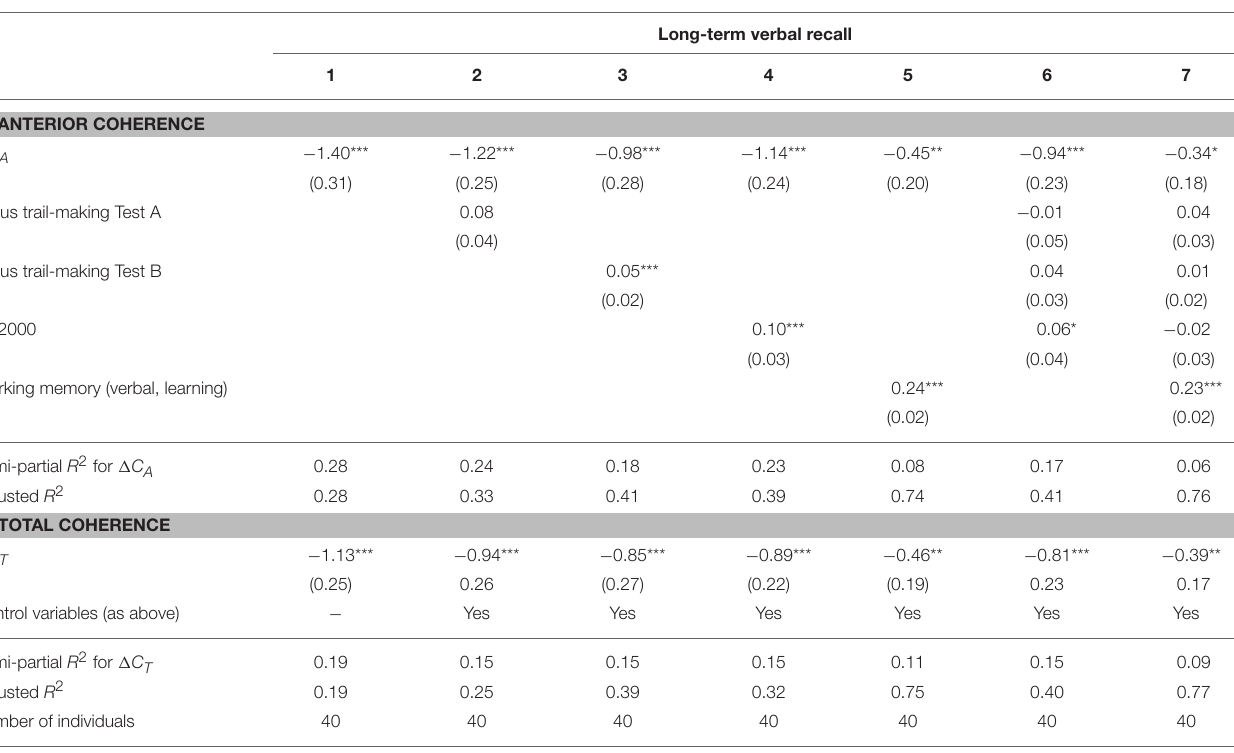
TABLE 3 | Linear regression of long-term memory on 1 C